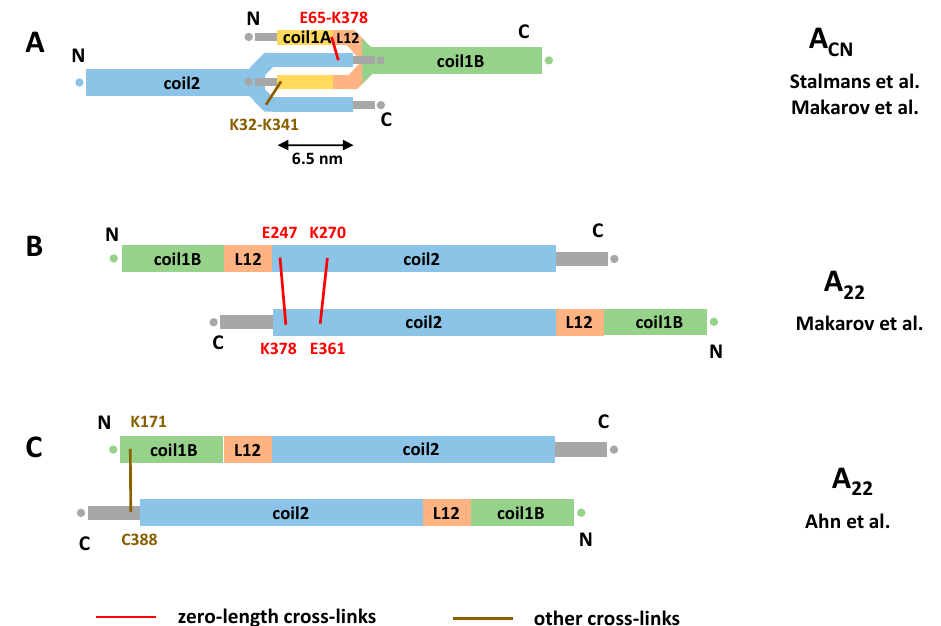
Figure 4. Dimer–dimer interactions for nuclear lamins as suggested from chemical cross-linking. ( A ) Longitudinal A CN overlap as suggested by Stalmans et al. and Makarov et al. [30,57]. ( B ) Lateral A 22 overlap as suggested by Makarov et al. ( C ) A 22 overlap as proposed by Ahn et al. [53].